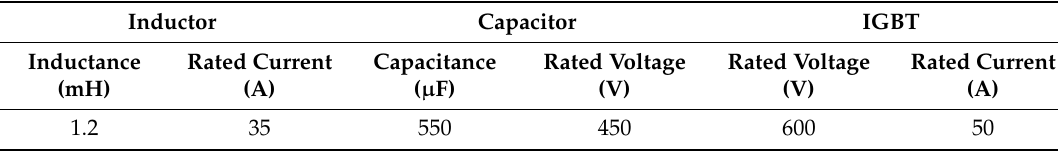
Table 2. Parameters of the ZSI.